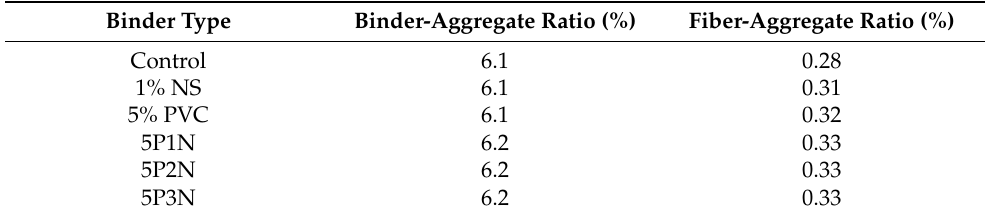
Table 6. Binder-aggregate and fiber-aggregate ratios of